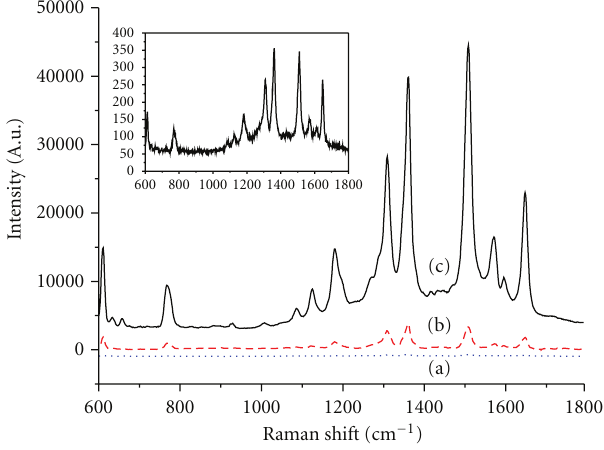
Figure 7: SERS spectra comparison of R6G molecules at the concentration of 10 − 6 M by using direct sampling and coated LCPCF: (a) direct sampling, (b) coated LCPCF detected from the unsealed end, and (c) coated LCPCF detected from the sealed end; inset: the enlarged SERS spectrum of direct sampling.